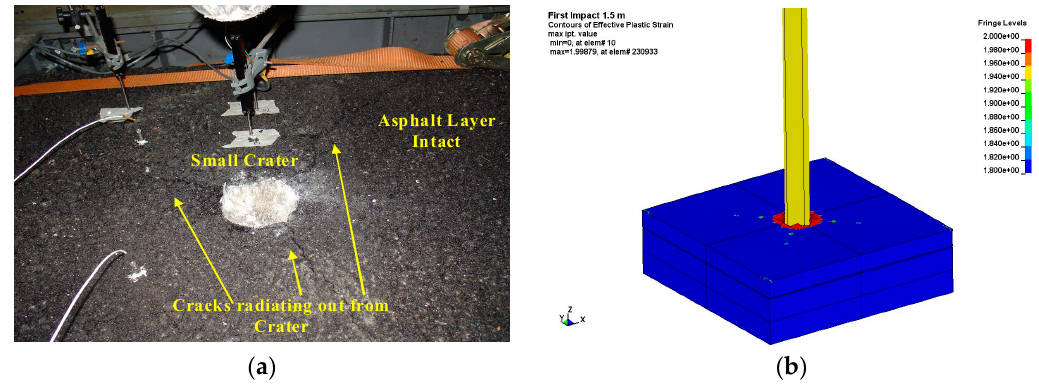
Figure 17. Damage of the multi ‐ layer slab after the first impact: ( a ) damage pattern of slab in the laboratory test; ( b ) damage pattern of slab in the numerical simulation.